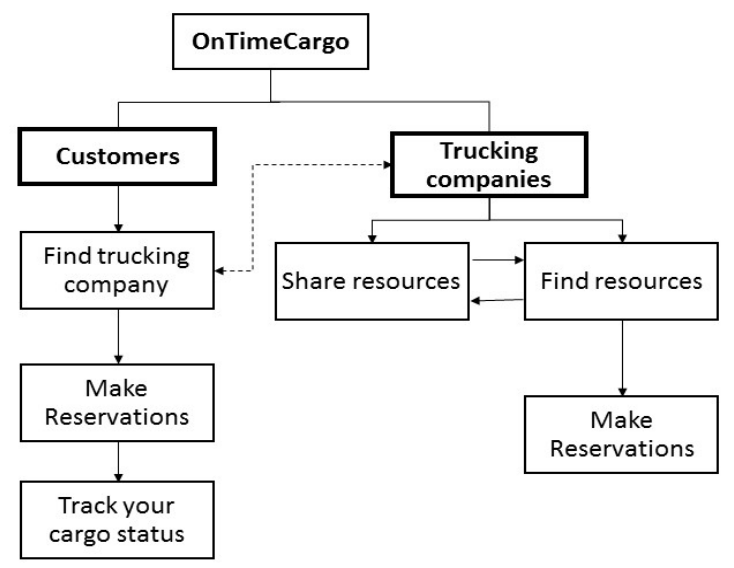
Figure 6. Information Architecture (IA) of the proposed system for cargo transportation.